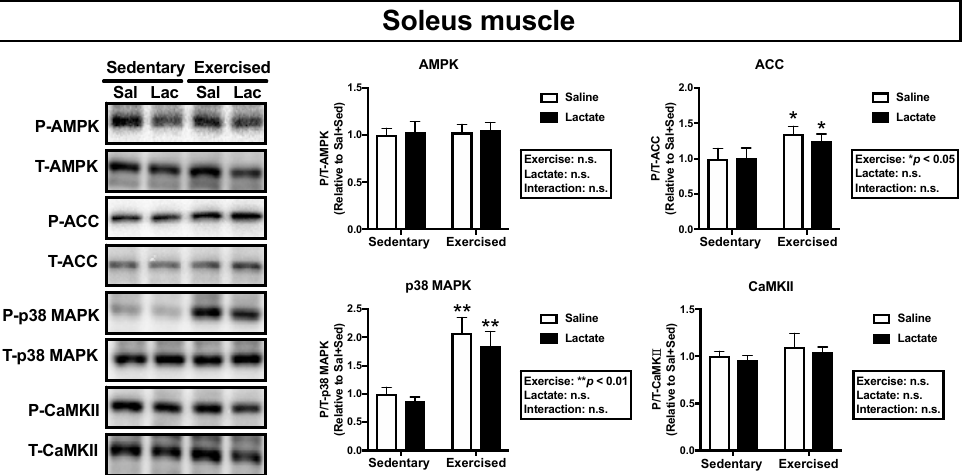
Figure 5. Phosphorylation of intramuscular signaling kinases in the soleus muscle 60 min after lactate ingestion (i.e., immediately after exercise). Data are presented as means ± SEM ( n = 8). * p < 0.05, ** p < 0.01: main effect of endurance exercise.